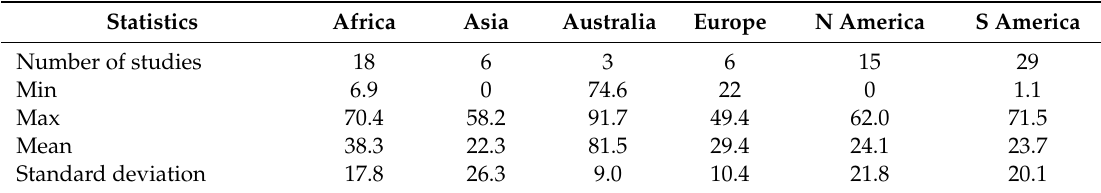
Table 3. Synopsis of the percentage (and dispersion measures) of venomous individuals within snake assemblages among continents, on the basis of the selected